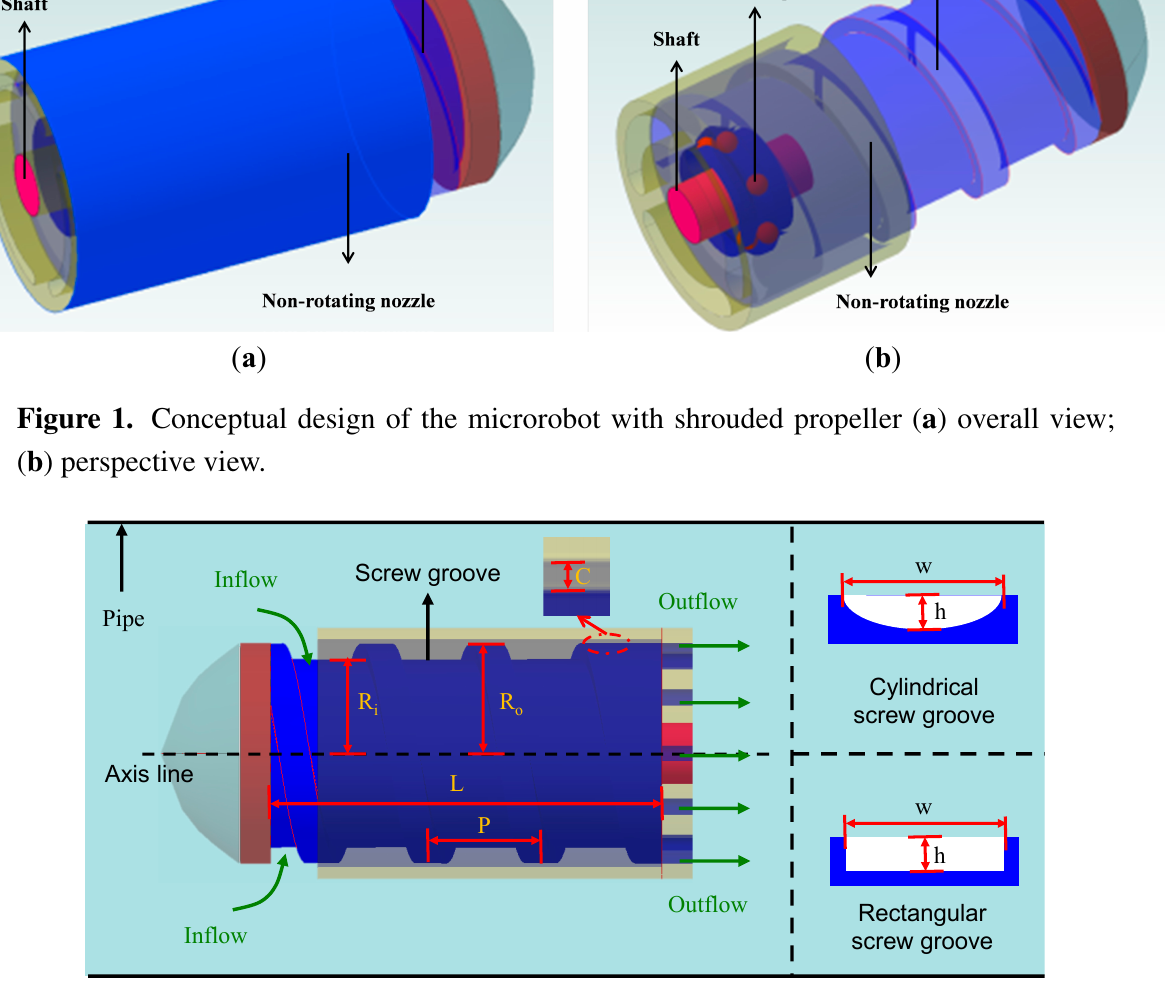
Figure 2. Propulsive force model.